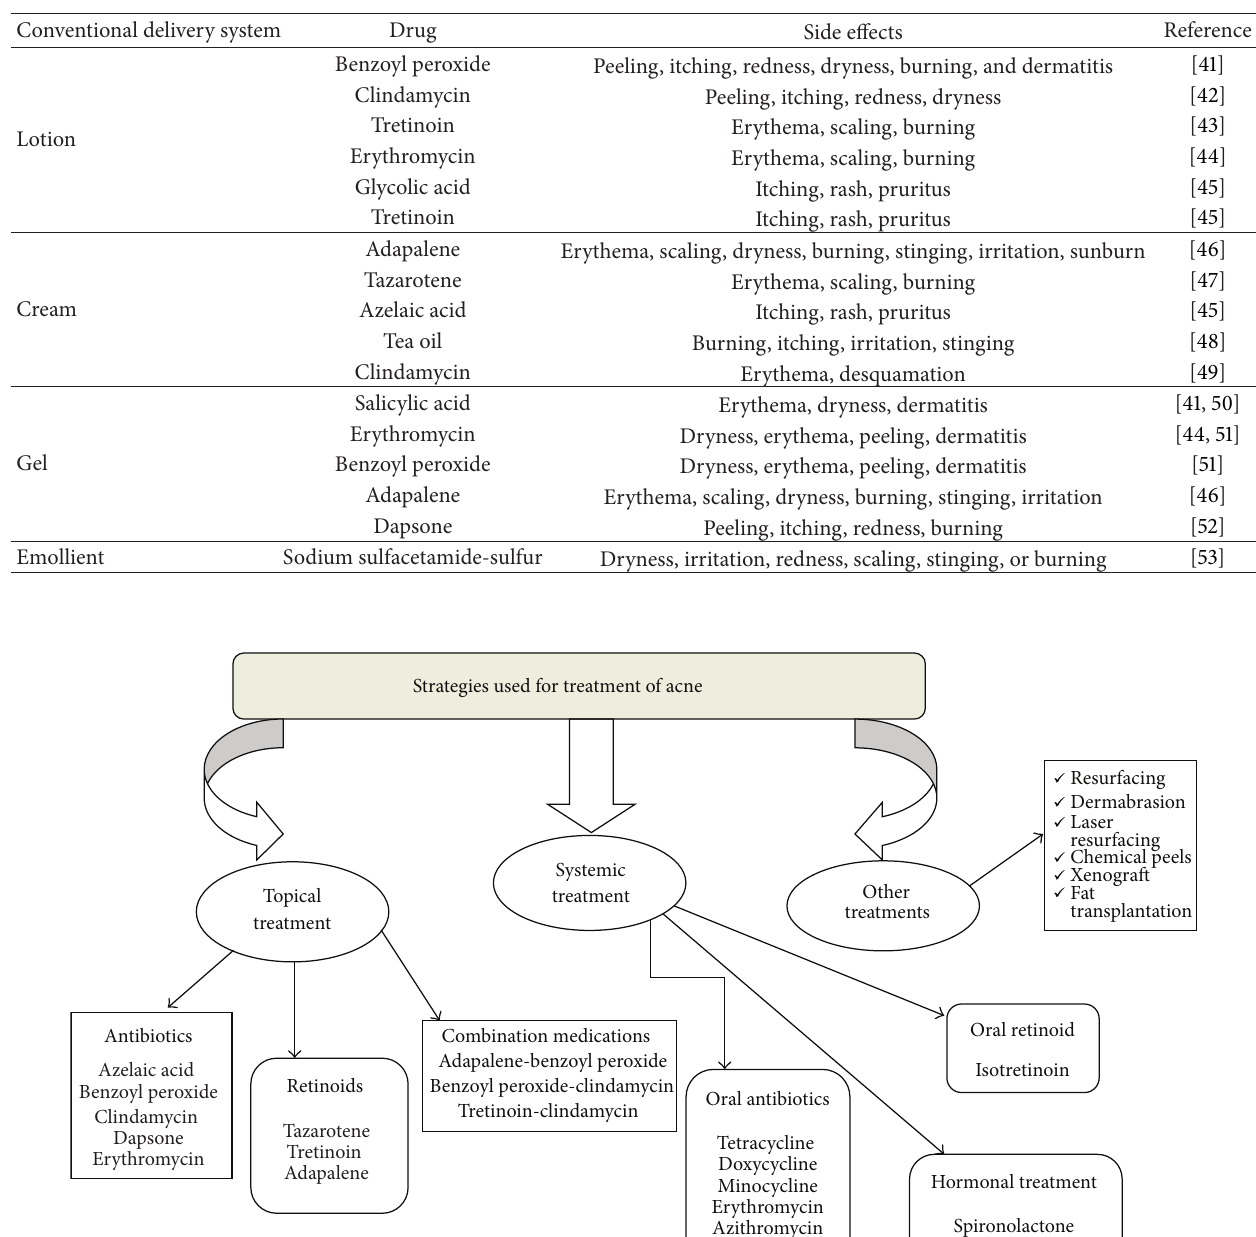
Table 4: Topical conventional delivery system used for acne.